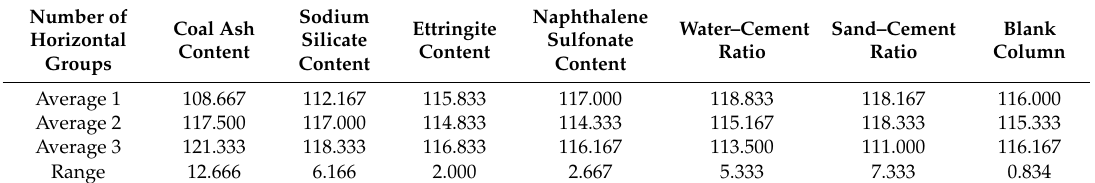
Table 6. Range analysis of bond stress.